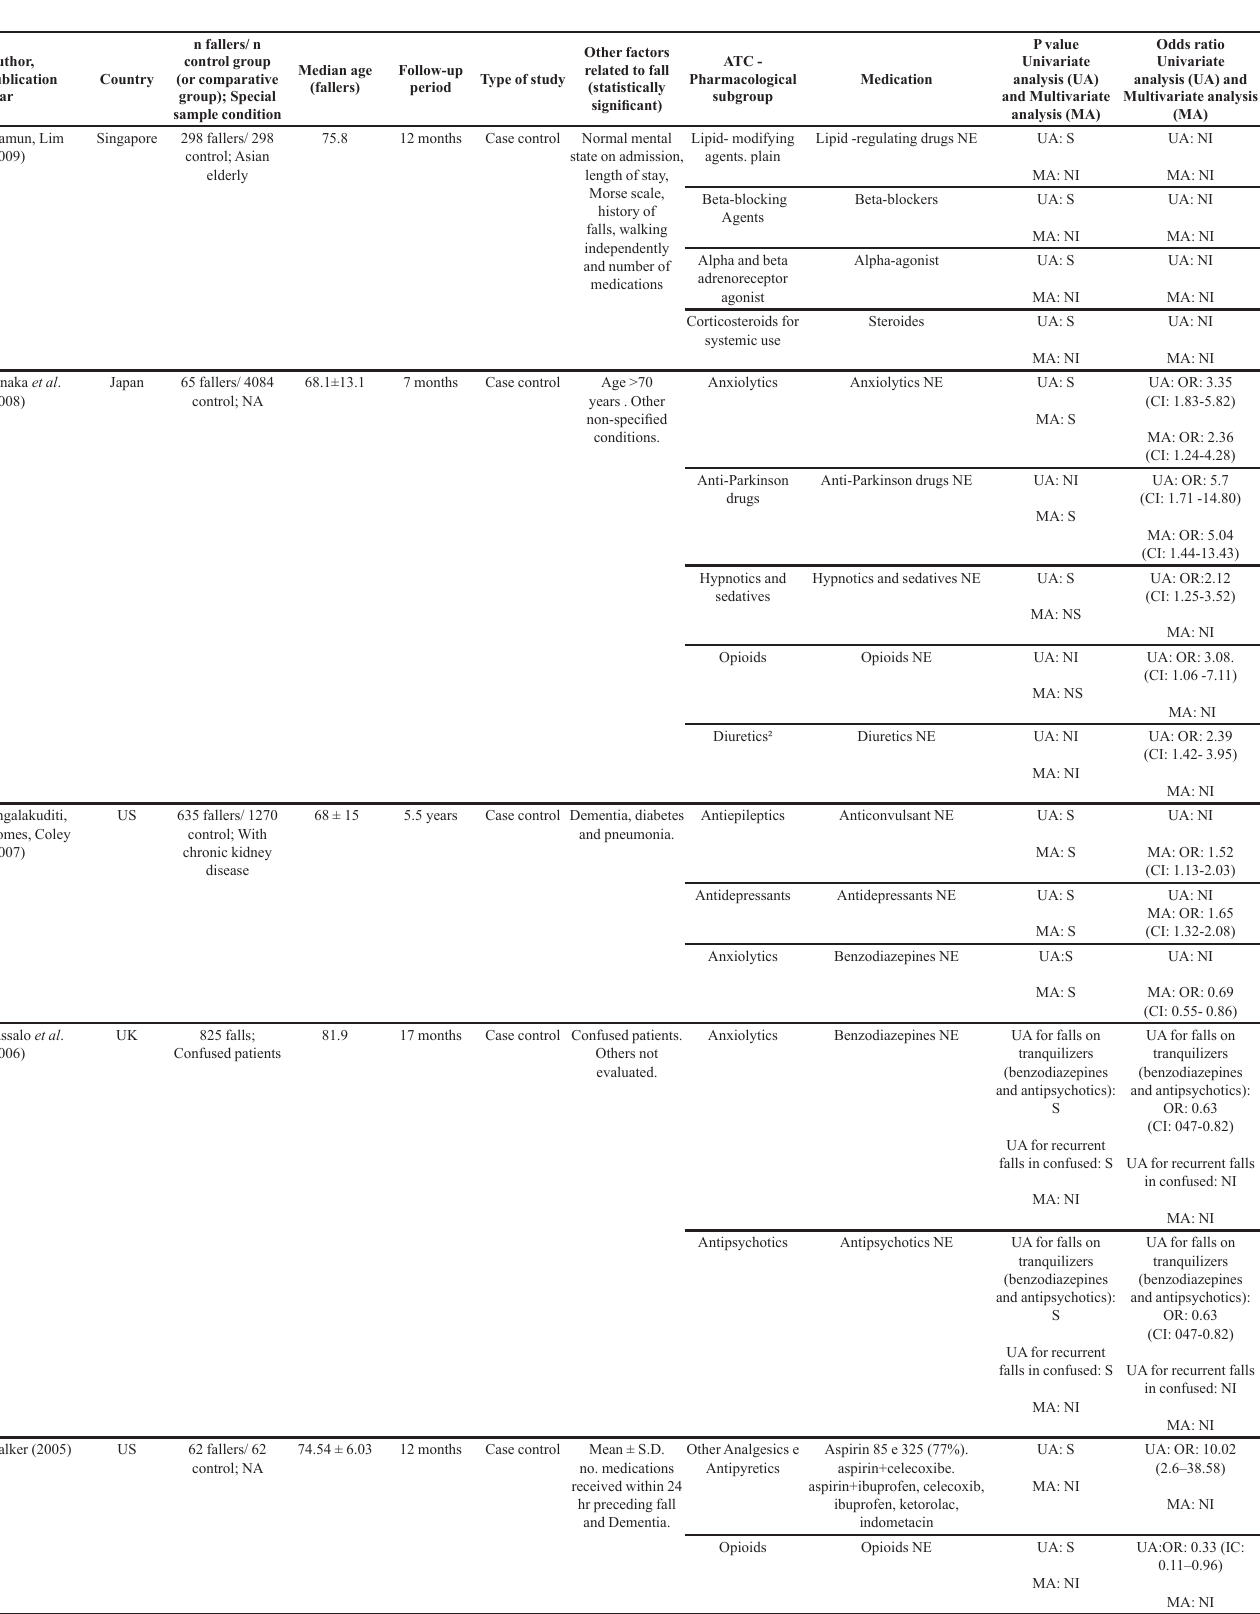
TABLE III - Eligible studies data